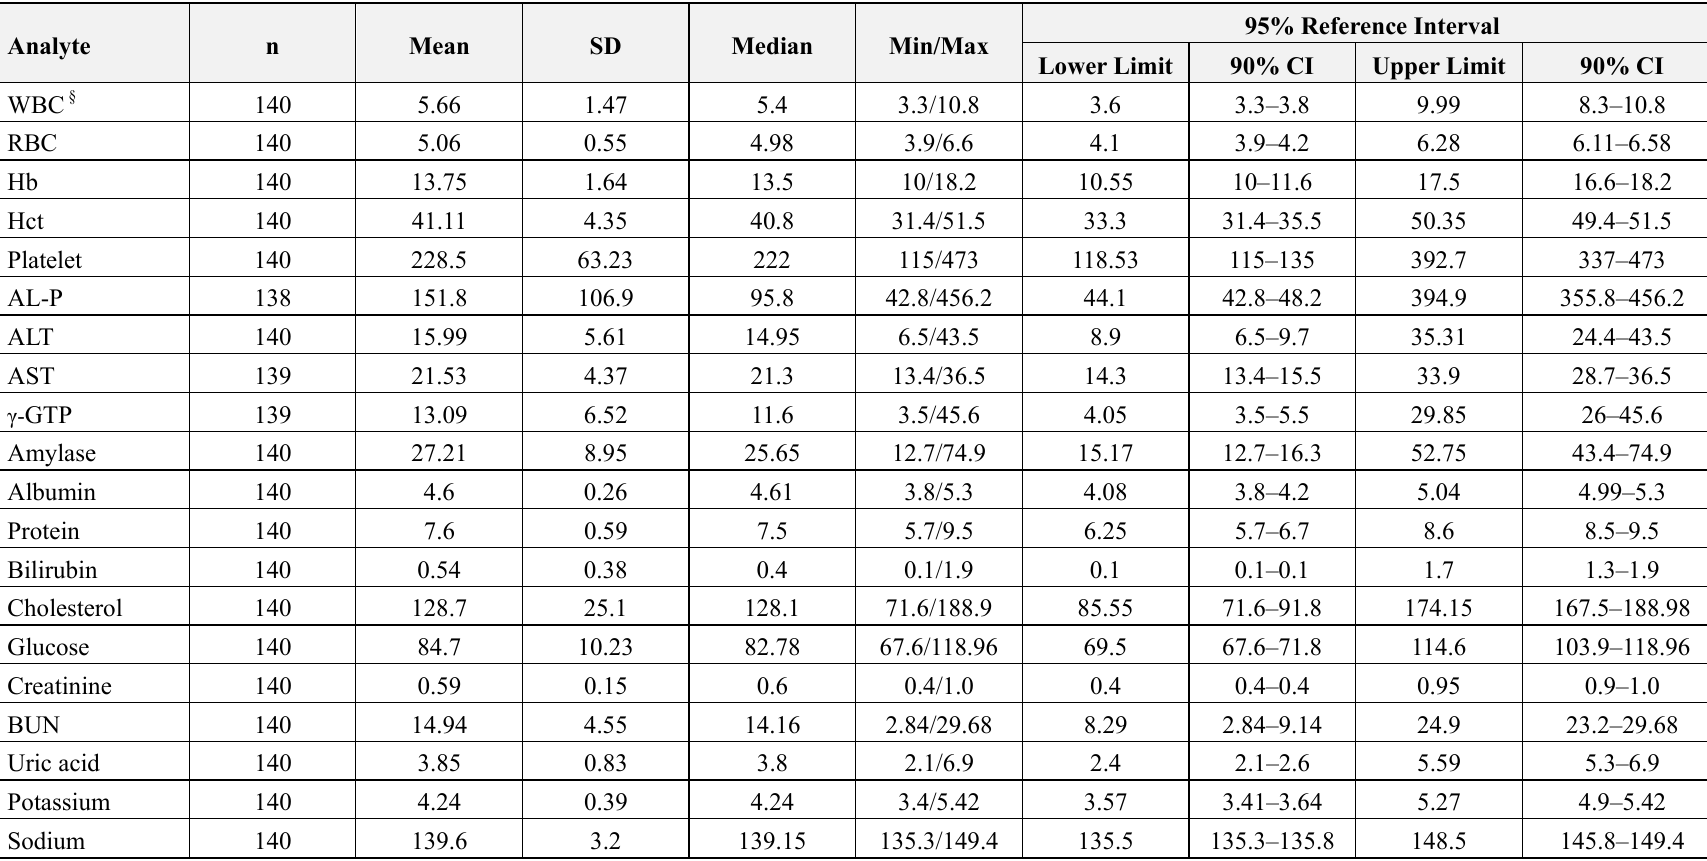
Table 2. Means, median and 95% percentile reference ranges for hematology and biochemistry analytes in 6–32 year